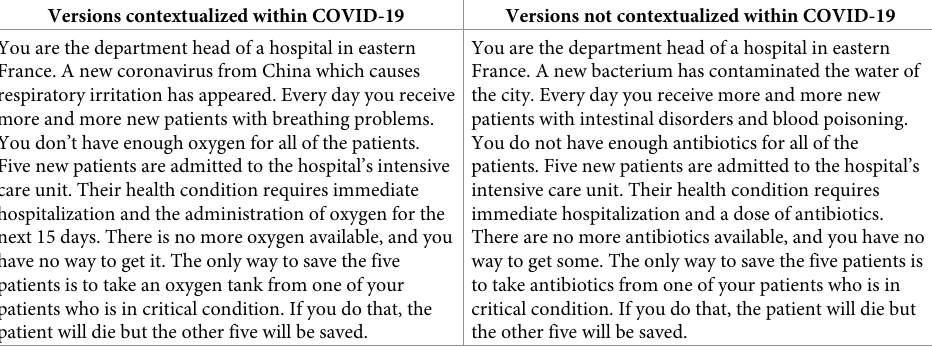
Table 1. Contextualized and non-contextualized versions of the TRIAGE dilemma used in experiment 1 (trans- lated from French). Versions contextualized within